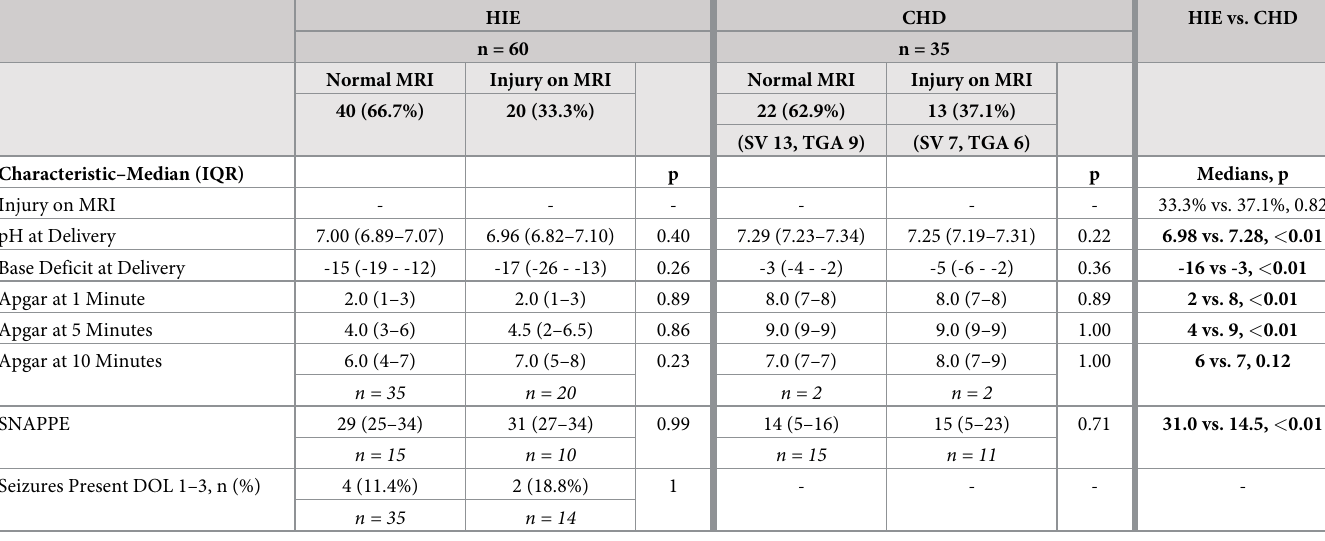
Table 2. Clinical